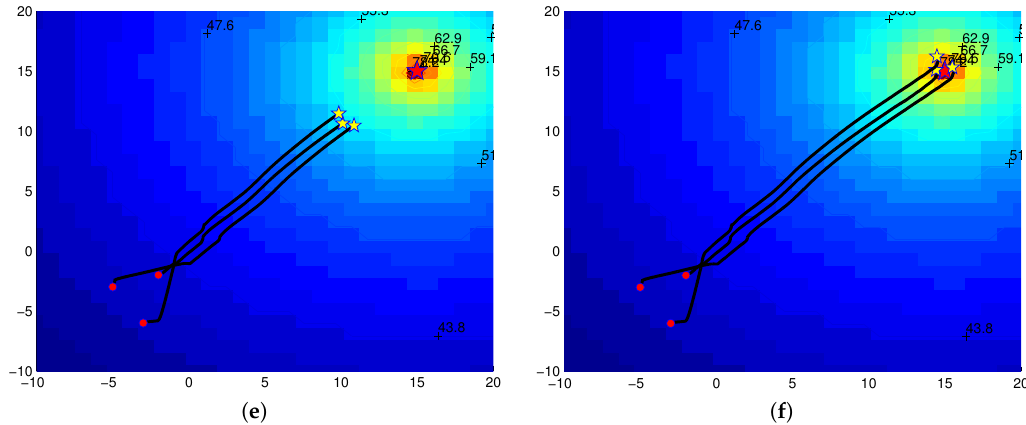
Figure 3. Movement trajectories of three robots for Case 1 where the red points denote the initial positions, the black lines are the trajectories of three robots, the yellow small stars are the current positions and the red big star refers to the signal source. The colors of the background represent the signal strength and are also labeled by the numbers. The signal strength increases with the decrease of the distance from the source. ( a ) t = 0 s; ( b ) t = 5 s; ( c ) t = 10 s; ( d ) t = 15 s; ( e ) t = 20 s; ( f ) t = 30 s.